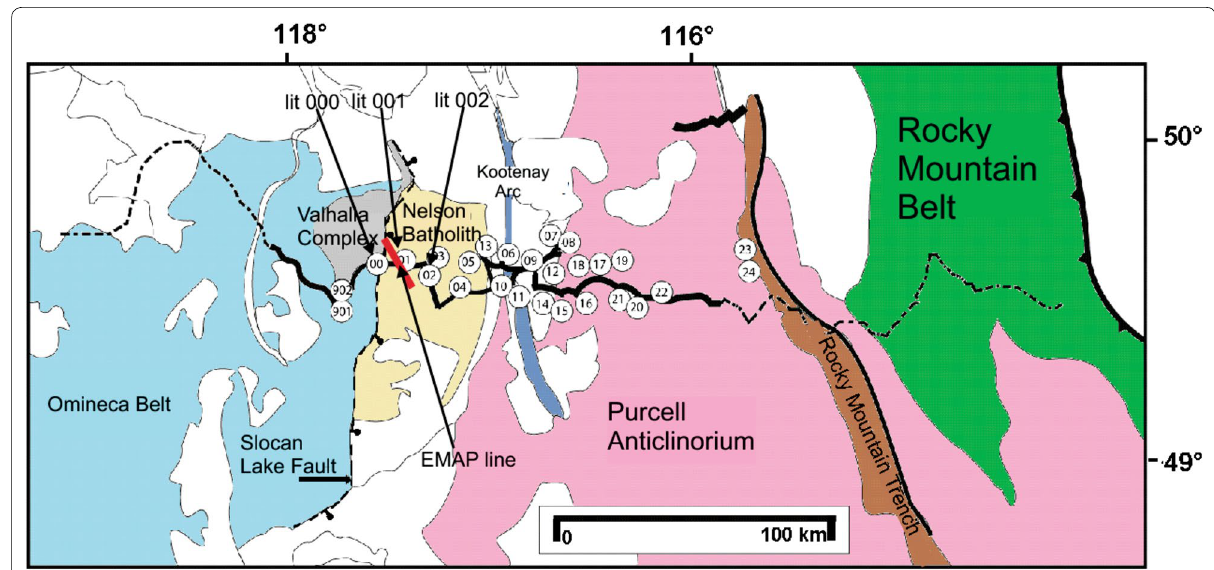
Fig. 3 Location of the MT sites of the BC87 dataset. We chose a profile 110 km long composed of 16 soundings between sites 902 and 022. The EMAP line is 10 km long and it is compared below with our results for the three indicated sites. The 16 sites are lit902, 00, 01, 02, 04, 05, 13, 06, 11, 09, 15, 16, 17, 19, 21 and 22